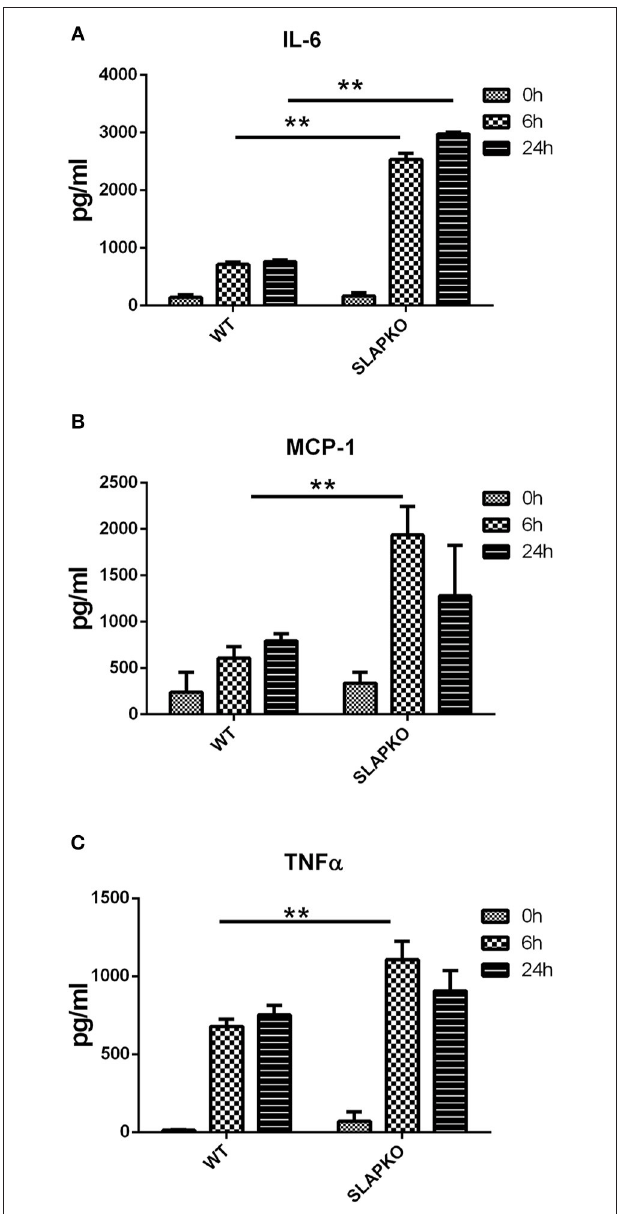
FIGURE 2 | SLAP KO BMMCs shows elevated levels of IgE induced cytokine release. BMMCs from WT and SLAP KO mice were sensitized with anti-DNP IgE and stimulated with DNP-HSA (10ng/ml) for 0, 6, and 24h at 37 ◦ C. Bar graph showing amount (pg/ml) of secreted (A) IL-6; (B) MCP-1; and (C) TNF α in collected cell supernatants at indicated times as determined by ELISA. Data in (A–C) show the means ± SD of a representative experiments done in triplicate, out of three independent experiments ( n = 3). (Student’s t- test; ** P < 0.01).